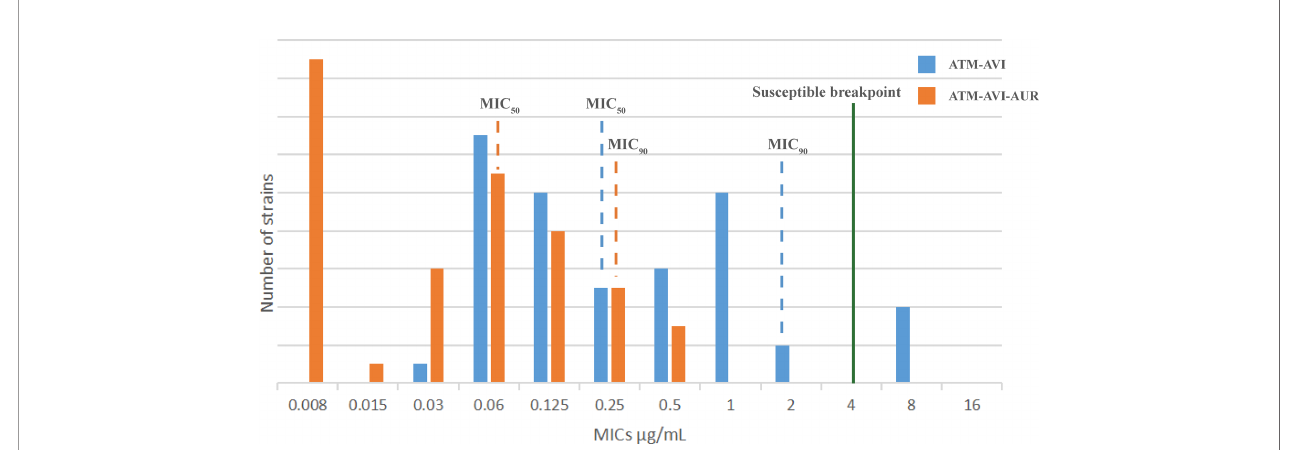
FIGURE 1 | The MIC distribution of the 51 MBL-producing clinical isolates to ATM/AVI with or without AUR. The MIC 50 /MIC 90 values of the 51 MBL-producing clinical isolates to ATM/AVI with or without AUR are shown. Isolates to the left of the green line are susceptible (for ATM-AVI, MICs are interpreted according to ATM of CLSI (2020), as there are no clinical breakpoints for ATM-AVI). With addition of AUR, the MIC 50 /MIC 90 values of the 51 MBL-producing clinical isolates to ATM/AVI move deeper into the “ susceptible zone ”